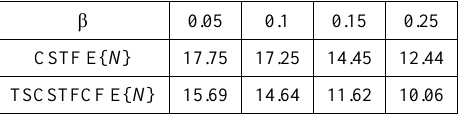
Table 9.Variation of the optimal E{ N } versus changes in